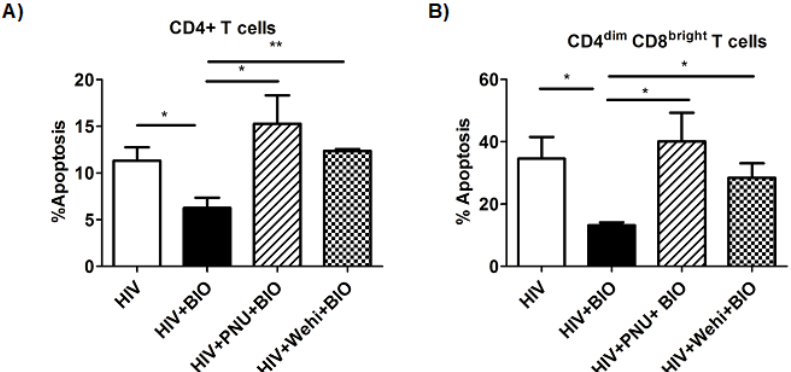
Figure 4. PNU-7465 (specific Wnt/ β -catenin pathway inhibitor) and WEHI-539 (specific Bcl-xL inhibitor) reverses mediated protection by Wnt/ β -catenin against HIV-induced cell death in T lymphocytes. Three-day-activated PBMCs were infected with HIV Bal for 6 h, washed and treated with 5 µM BIO, PNU-74654 at 50 µM, or WEHI-539 at 5 µM or vehicle after 24 h of infection. ( A , B ) Cumulative data of apoptosis mean percent on day 6 post infection and treatment with PNU-7465 and WEHI-539 in CD4+ and CD4 dim CD8 bright T cell populations. Flow data were collected on a FACS Canto II flow cytometer with the BD FACSDiva software (BD Biosciences, Franklin Lakes, NJ, USA) and analyzed using the FlowJo software. Data are represented as mean ± SEM and analyzed using a two-tailed one-sample t test. * means p ≤ 0.05, ** p ≤